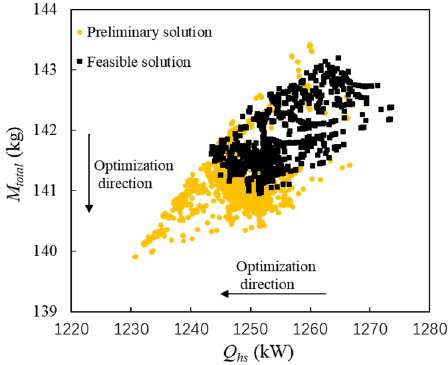
Figure 8. System-level optimization results after feasible selection with SEG method.